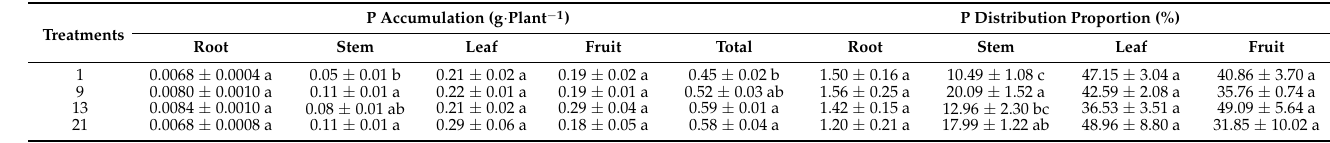
Table 4. Effects of continuous cropping on P uptake and distribution of cucumbers in the solar greenhouse.